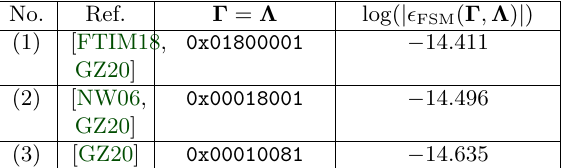
Table 1: The best bitwise mask tuples ( Γ , Λ ) for the linear approximation (1) in [GZ20] No. Ref. Γ = Λ log( | (cid:15) ( Γ , Λ ) | ) FSM (1) [FTIM18, 0x01800001 − 14 . 411 GZ20] (2) [NW06, 0x00018001 − 14 . 496 GZ20] (3) [GZ20] 0x00010081 − 14 .